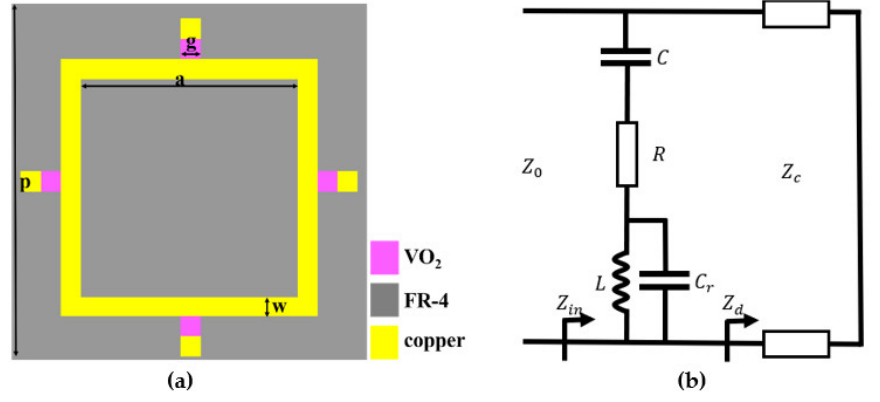
Figure 2. The model of the metamaterial absorber ( a ) and the equivalent circuit ( b